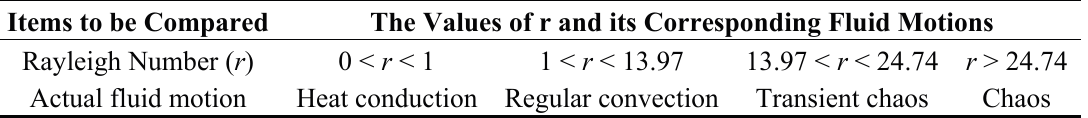
Table 1. The actual fluid motions in Lorenz system when parameters σ and b are respectively equal to 10 and